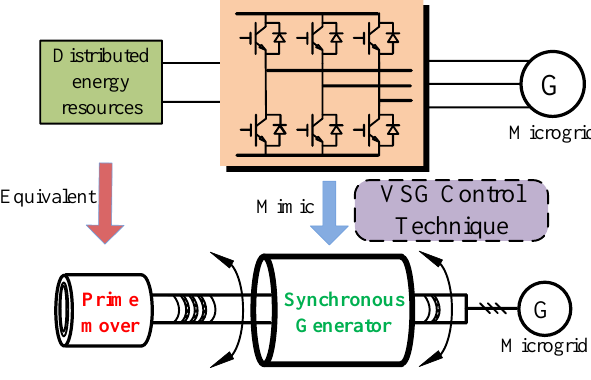
Figure 1. Concept of a virtual synchronous generator. Table 1. The Swing equation with type SI and type pu.